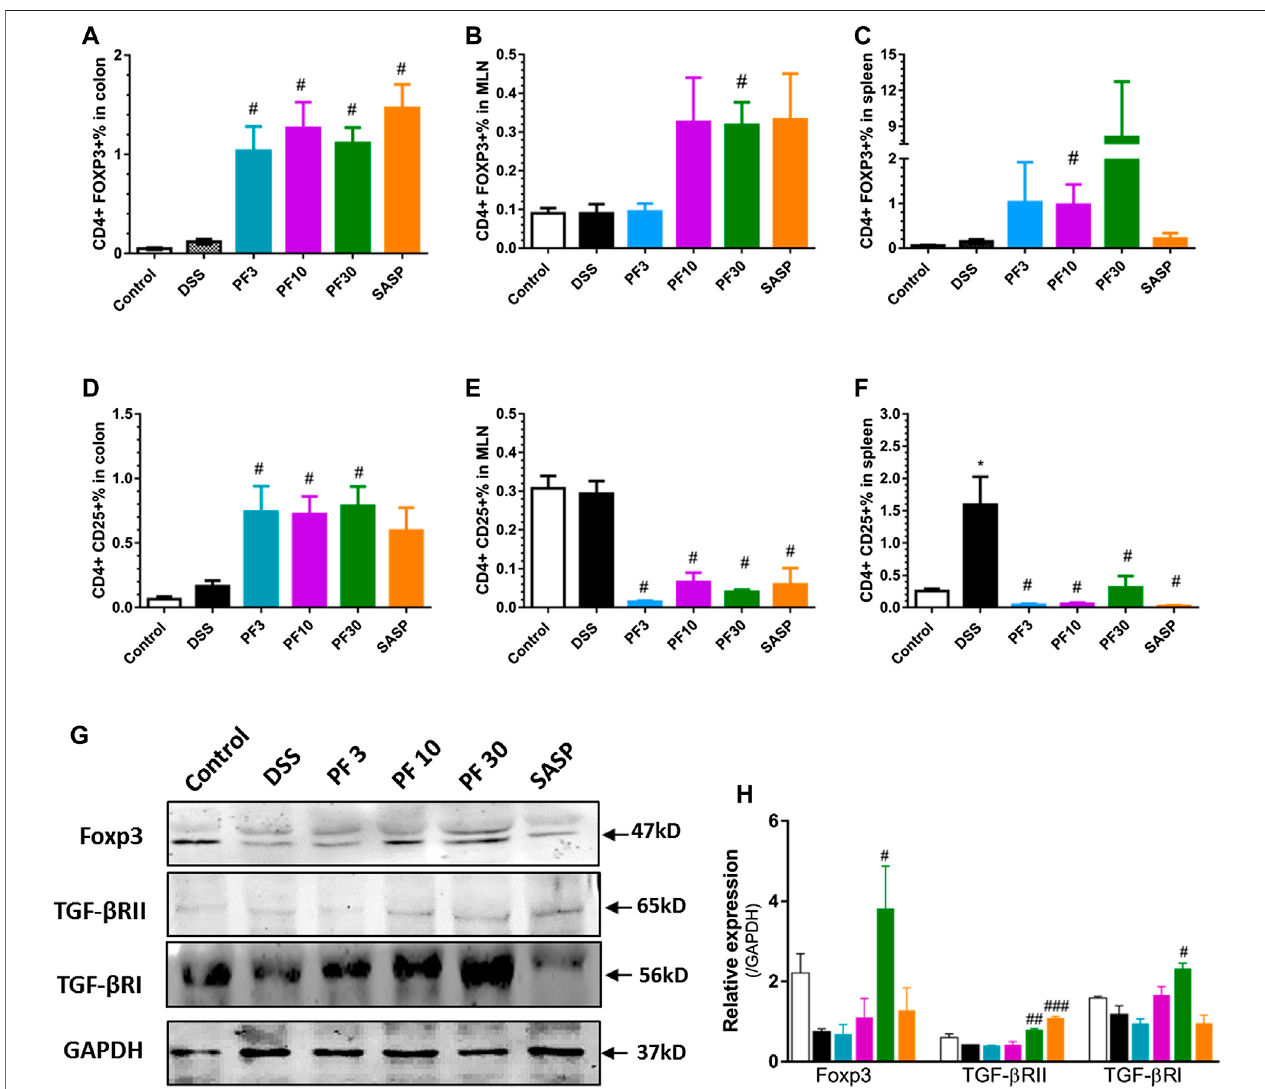
FIGURE6| PF-04447943upregulatedTregcellsinDSSinducedcolitis. (A-C) PercentofCD4 + Foxp3 + cellsinthecolon (A) ,MLN (B) andspleen (C) ,respectively. (D-F) PercentofCD4 + CD25 + cellsin thecolon (D) ,MLN (E) , and spleen (F) ,respectively. (G) Expression ofFoxp3,TGF β RII,TGF β RI, and GAPDH incolon assessed by western blot. (H) Relative expression of Foxp3, TGF β RII and TGF β RI, successively. Data are presented as mean ± standard error mean (SEM) ( n (cid:1) 2 – 5). Here, *** p < 0.001, ** p < 0.01, * p < 0.05 vs. control group and ### p < 0.001, ## p < 0.01, # p < 0.05 vs. DSS-treated group.